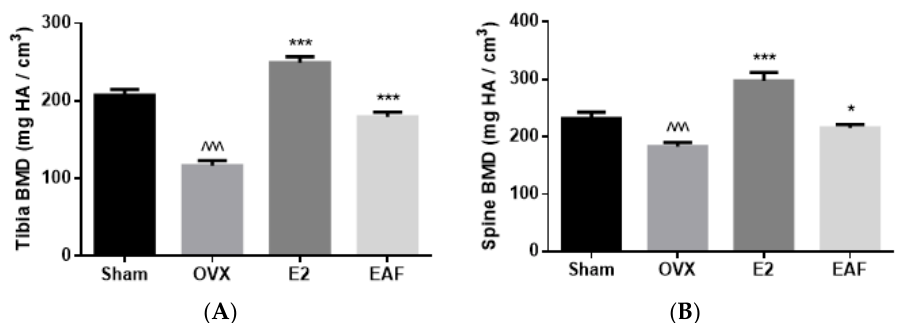
Figure 2. ( − )- epi afzelechin (EAF) improved bone mineral density (BMD) in the proximal tibia ( A ) and lumbar vertebra L4 ( B ) of ovariectomized C57BL/6J mice. Mature ovariectomised (OVX) or sham-